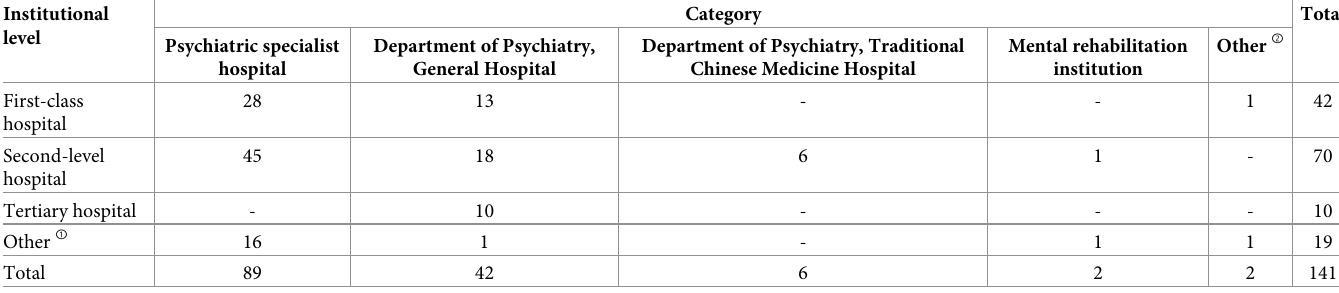
Table 2. General information of mental health institutions. Institutional